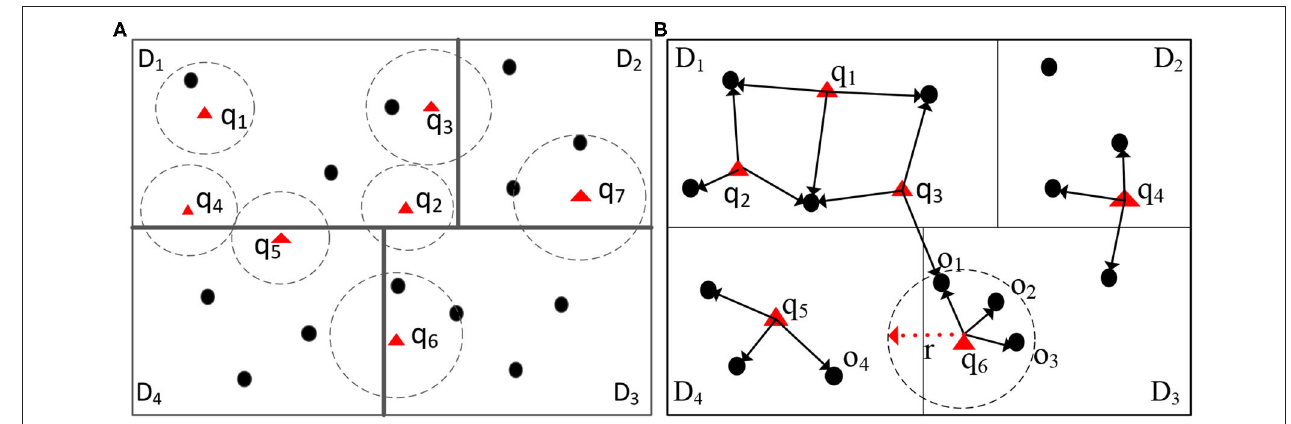
FIGURE 1 | Illustration of spatial join and kNN join operators. Circles centered around the triangle focal points form one dataset, and the black dots form the second dataset. Spatial range join returns (dot, triangle) pairs when the dot is inside the circle. kNN join returns (triangle, dot) pairs when the dot is among the three nearest dots to the triangle. (A) Range join, (B) 3NN